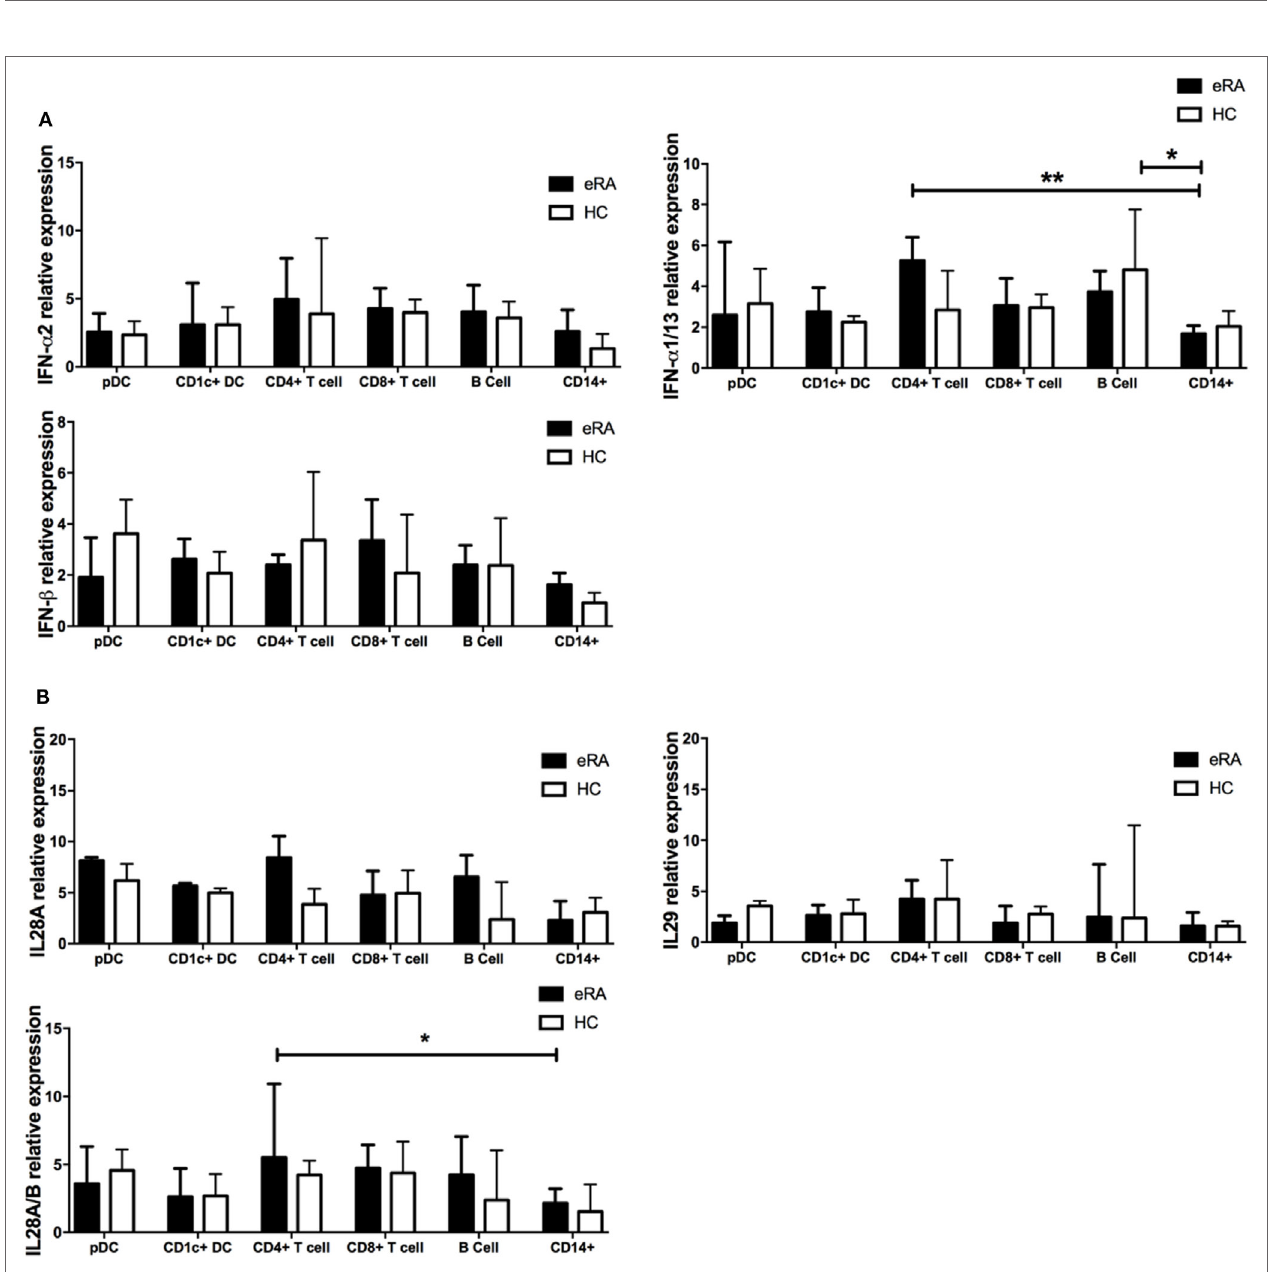
FigUre 3 | Plasmacytoid DCs (pDCs), CD1c + DC, and CD141 + DC phenotype is different in early rheumatoid arthritis (RA) and changes with initiation of therapy. (a) pDC, (B) CD1c + DC, and (c) CD141 + DC cell surface marker expression of CCR7, CD86, HLA-DR, and CD40 was quantified by flow cytometry [median fluorescence intensity (MFI)] in healthy controls (HC, n = 30) and early RA patients [ n = 30–32; further split into seronegative ( n = 5–7) and seropositive ( n = 25) early RA]. Horizontal lines depict median values. Mann–Whitney U tests (D) pDC, CD1c + DC, and CD141 + DC CCR7 MFI plotted (linear regression) against circulating DC frequency in all seropositive early RA patients ( n = 25). (e) pDC, (F) CD1c + DC cell, and (g) CD141 + DC surface marker expression was quantified in an early RA cohort ( n = 15) at baseline and at 1, 3, 6, and 12 months after diagnosis. Each line represents an individual patient. Wilcoxon signed rank tests. * p < 0.05, ** p < 0.01, *** p <